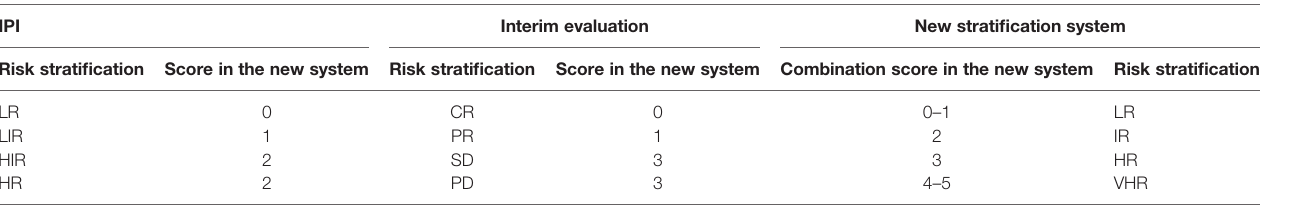
TABLE 2 | The new strati fi cation system combining IPI and interim evaluation. IPI